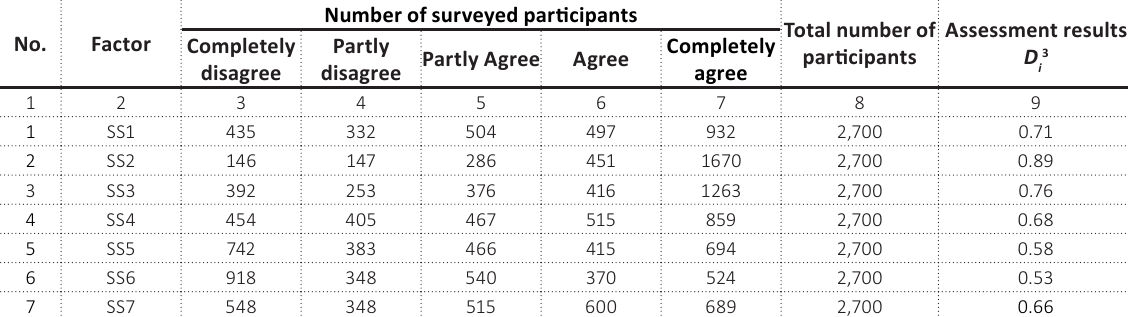
Table 5. Effectiveness of smart student (SS)